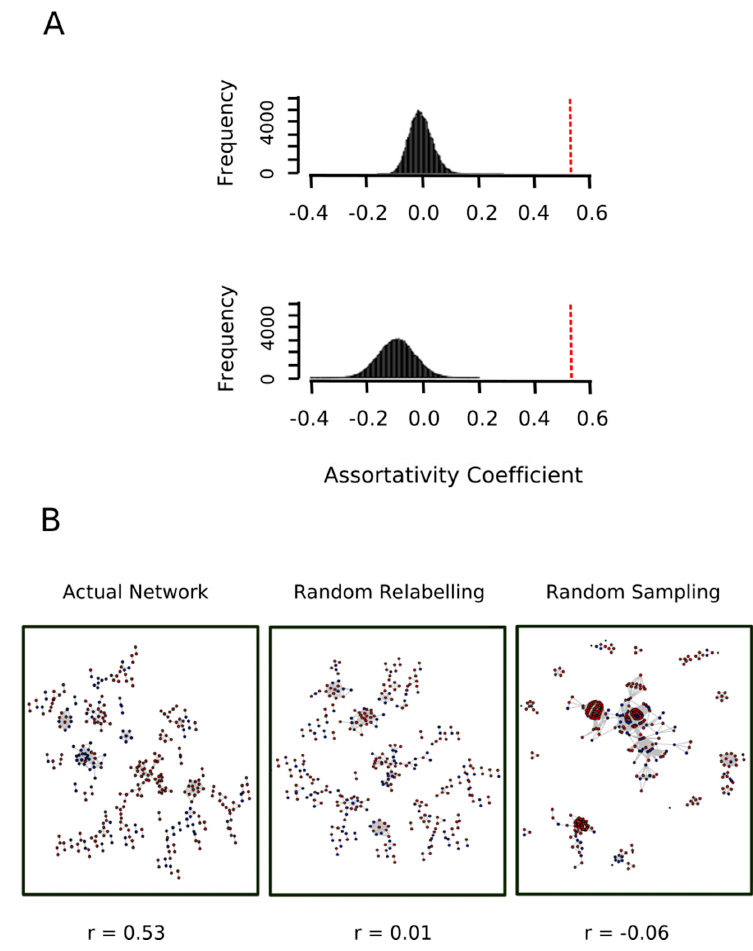
Figure 8. Proteins oxidized ex vivo and in vitro show a significant assortative mixing. ( A ) The nodes in the actual network shown in Figure 7 were randomly relabeled either as a red node or a blue node then the assortativity coefficient of the relabeled network was computed. This process was repeated 10,000 times and the assortativity coefficient distribution was plotted (top plot in panel A). On the other hand, the whole human proteome network was sampled to obtain 10,000 random subnetworks containing as many nodes as the actual network shown in Figure 7. For each of these subnetworks, 1113 nodes were randomly labeled as “red” and the remaining 503 nodes were labeled as “blue” and its assortativity coefficient was computed. The bottom plot in panel A shows the distribution of the assortativity coefficient in this random sampling experiment. The vertical red dashed lines indicated the value of the assortativity coefficient for the actual network shown in Figure 7. ( B ) The actual network and representative networks of the random relabeling and random sampling experiments are shown in B after removing isolated nodes (nodes with degree 0). To further strengthen this conclusion, we carried out a second control test where the topology of the network was not kept constant. In other words, we put forward the null hypothesis that the two sets (proteins exclusively oxidized ex vivo, set A, and protein exclusively oxidized in vitro, set